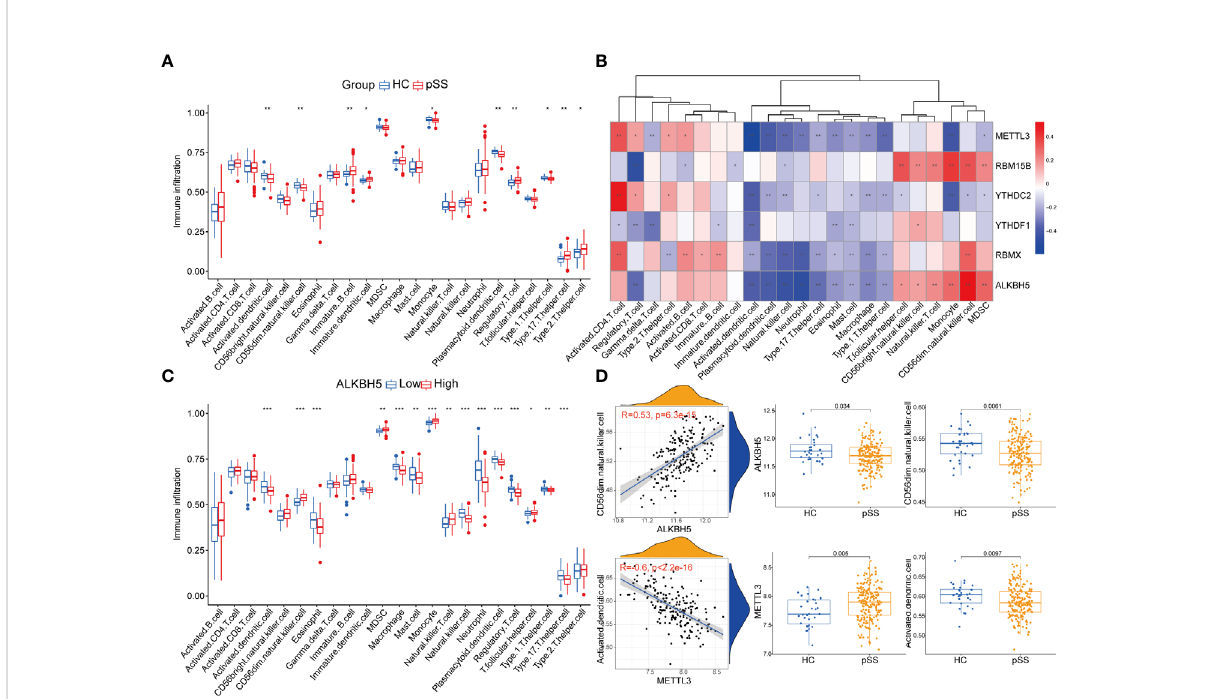
FIGURE 4 Immune microenvironment characteristics in pSS. (A) The immune score differences of each immune microenvironment in fi ltrating immunocyte in HCs and pSS. (B) The correlation matrix between the immune score and the 6 DEMRs. (C) The correlation between immune score and ALKBH5. (D) ALKBH5 and METTL3 showed a comprehensive linkage with the in fi ltrating immune cells. As for ALKBH5, the most correlated pair is ALKBH5 - CD56dim natural killer cells, the expression differences of ALKBH5 and activated dendritic cells in HCs and pSS is presented by dot plots at the top. As for METTL3, the most correlated pair is METTL3 – activated dendritic cells, the expression differences of METTL3 and activated dendritic cells in HCs and pSS is presented by dot plots at the bottom. *, p<0.05; **, p<0.01; ***,